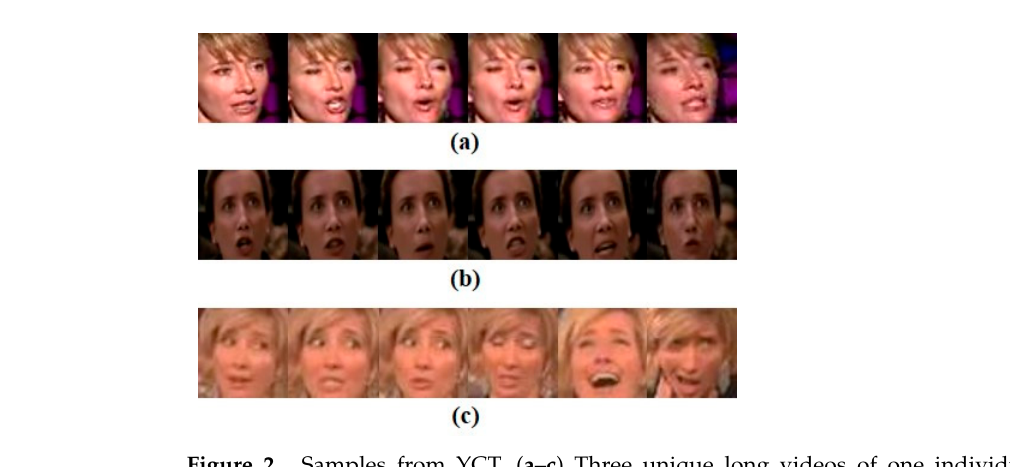
Figure 2. Samples from YCT. ( a – c ) Three unique long videos of one individual in the YTC database [51].